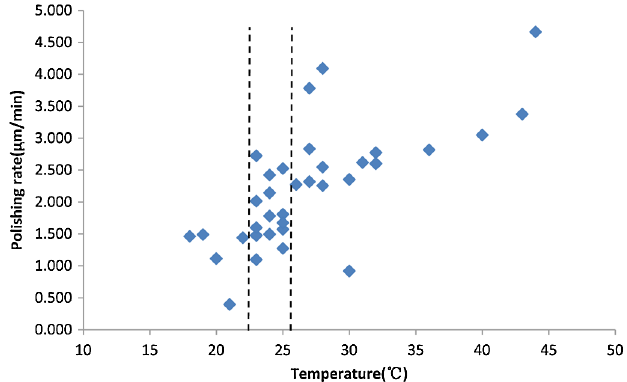
FIG. 6. (Color) The effect of flow rate of electrolyte on polishing rate from all the experiments including those with different temperatures.